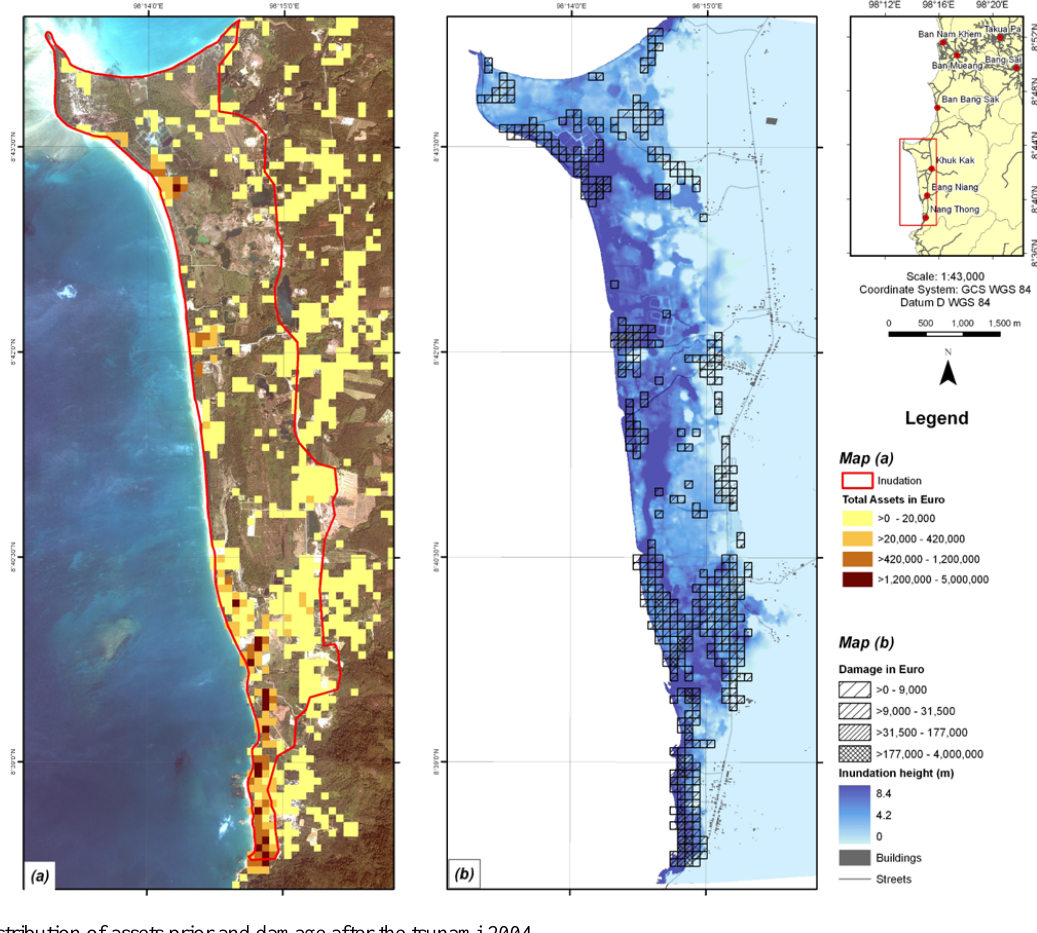
Fig. 10. Distribution of assets prior and damage after the tsunami 2004.